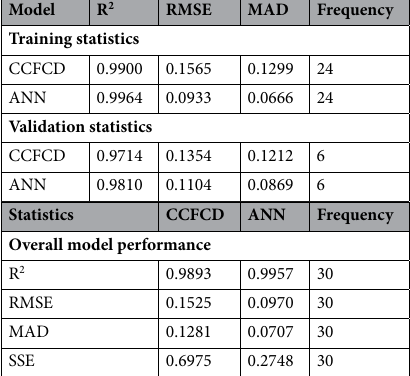
Table 5. The performance of CCFCD and ANN models for CNPs biosynthesis by Streptomyces microflavus strain NEAE-83. RMSE; root mean squared error, MAD; mean absolute deviation, SSE; the sum of squares error.